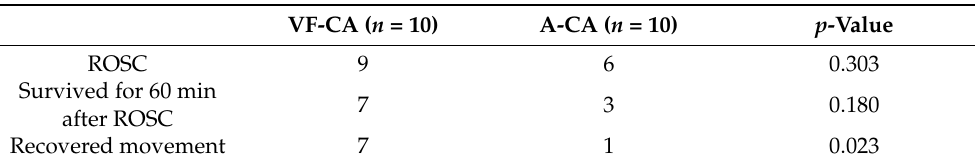
Table 3. Outcomes of subjects in the ventricular fibrillation cardiac arrest (VF-CA) and asphyxial cardiac arrest (A-CA)